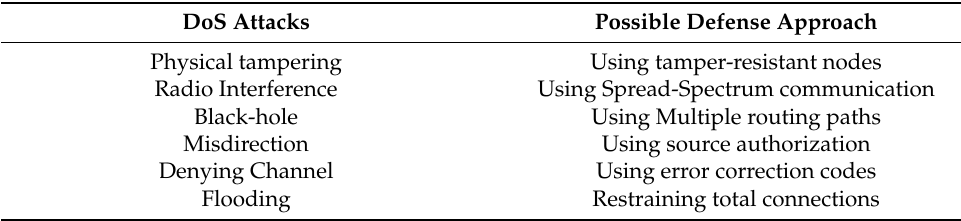
Table 4. Defensive measures against DOS attacks in WSN.